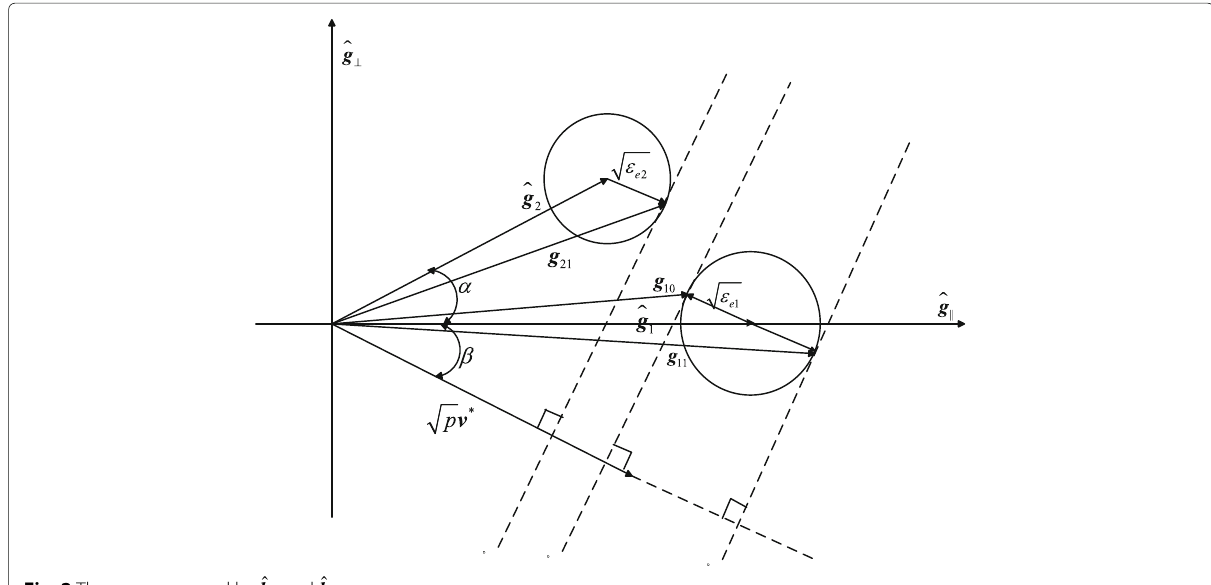
Fig. 2 The space spanned by ˆ h (cid:4) and ˆ h